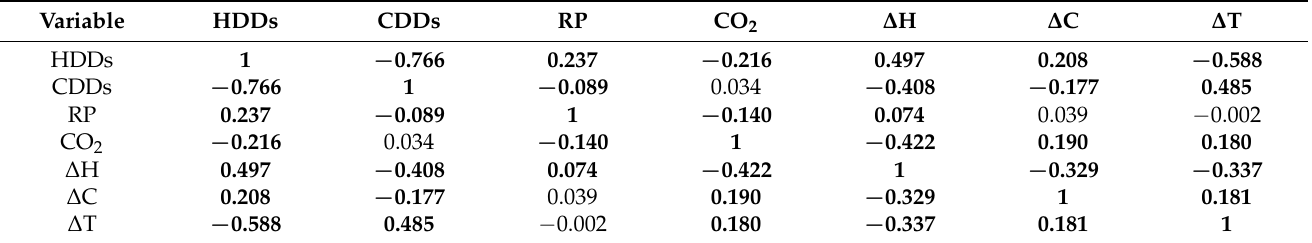
Table 7. Spearman rho coefficients.